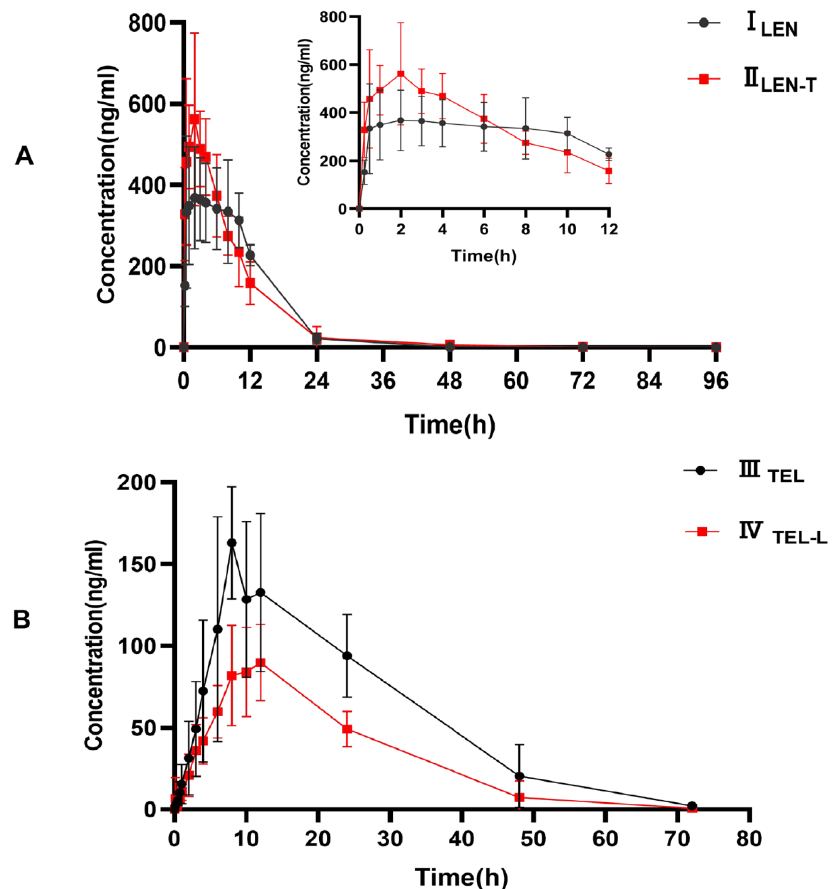
The main pharmacokinetic parameters are expressed as the mean ± standard deviation, and T max (h) is expressed as the median (range).